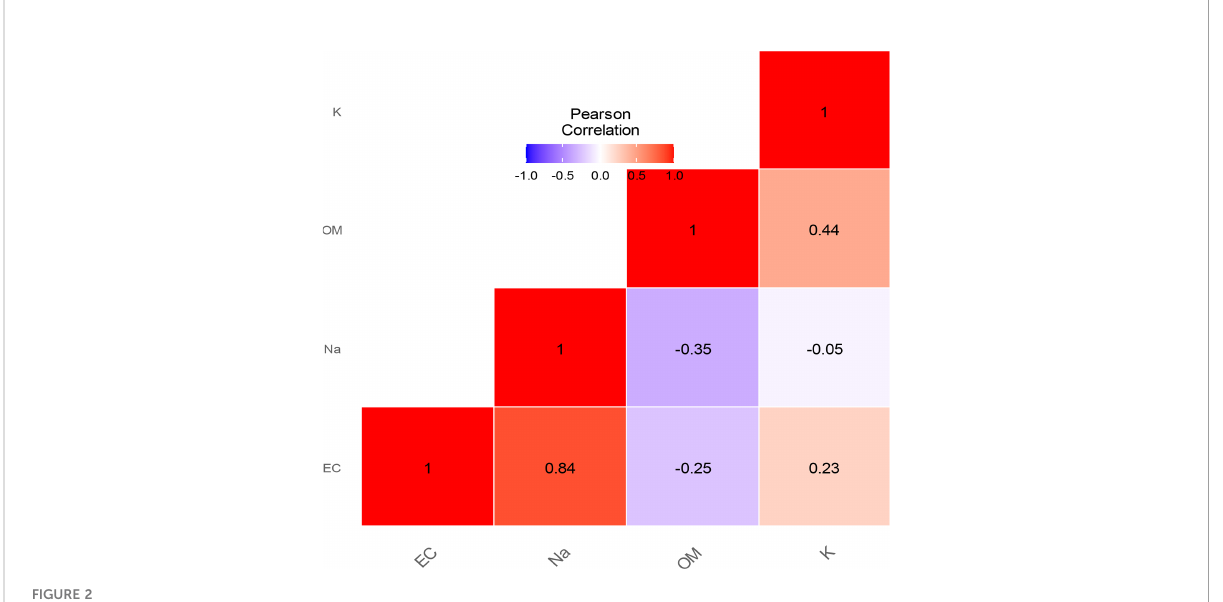
FIGURE 2 Pearson correlation between EC, Na, OM, and